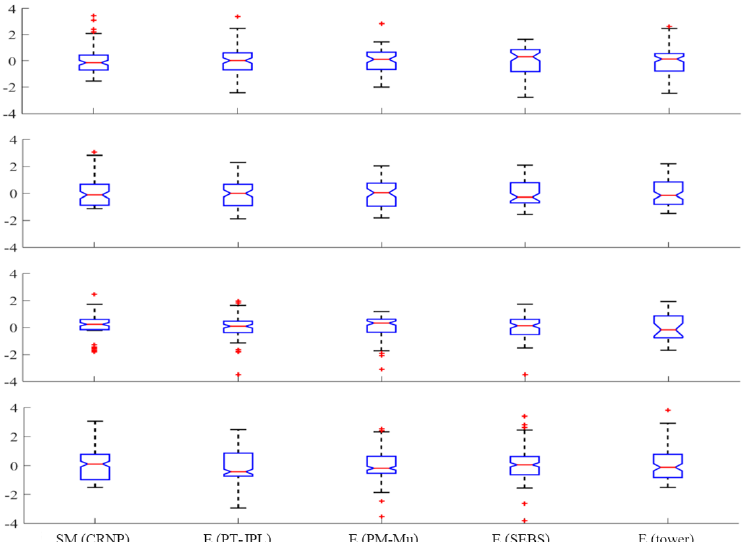
Figure 7. ANOVA boxplots of standardized CRNP soil moisture, and standardized evaporation estimates and observations for each defined period of